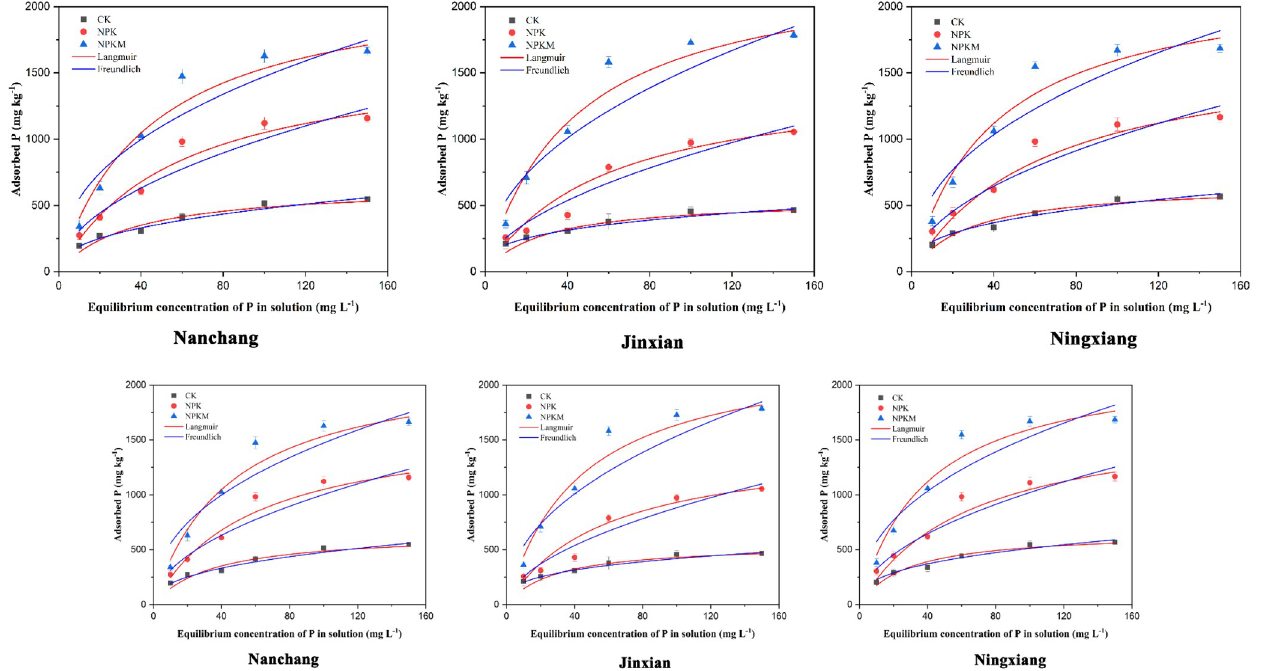
Fig 1. The adsorption isotherms of P in red paddy soils under three different long-term experimental sites.